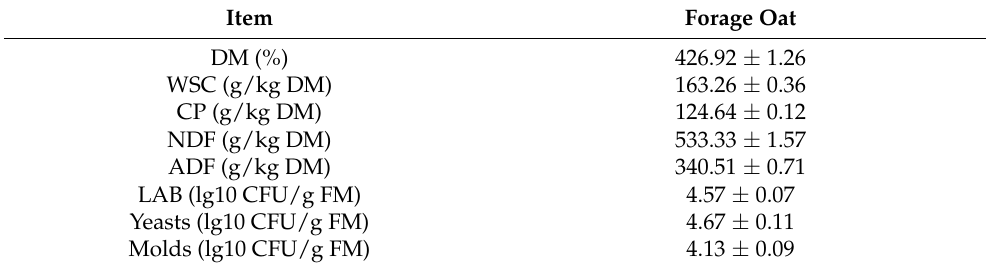
Table 2. Chemical compositions and microbial populations of forage oat by plate culture before ensiling. Item Forage